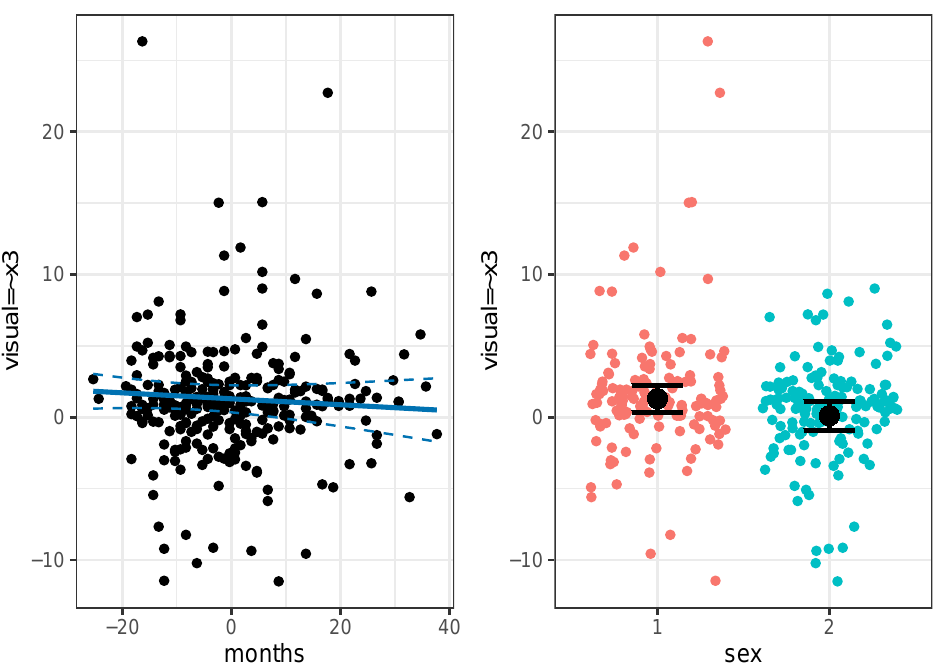
Figure 4. Estimated conditional differences in the factor loading of the indicator x3 . Left plot: IPCs to the factor loading are plotted on the students’ age in months. The solid blue line marks the estimated factor loading as a function of months when all other covariates are zero. The dashed blue lines represent the upper and lower limit of the 95% pointwise confidence bands. Right plot: IPCs to the factor loading are plotted on the students’ gender. The big dots mark the estimated factor loadings for girls and boys when all other covariates are zero. The error bars indicate the 95% confidence intervals of the estimated gender-specific factor